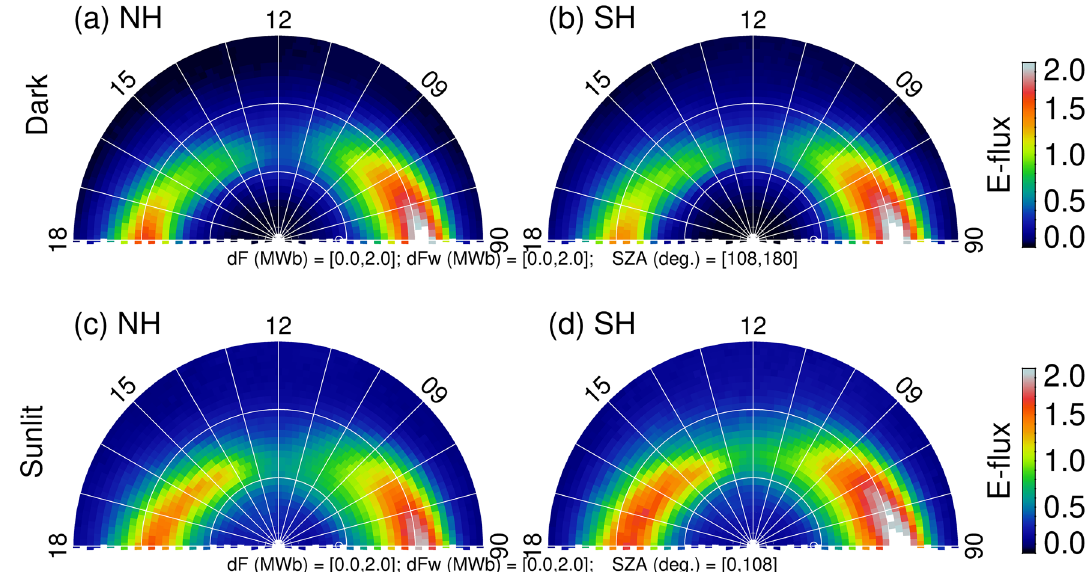
Figure 2. Averaged dayside auroral particle energy flux under ( a , b ) dark and ( c , d ) sunlit conditions for all solar 〈 d 〉 = 0–2.0 MWb/s). The figure is produced by the first author wind driving ( d MP /dt = 0–2.0 MWb/s and MP / dt using the Interactive Data Language (IDL) software version 8.2.3. The ULR link for IDL is https ://www.harri ϕ ϕ sgeos patia l.com/.